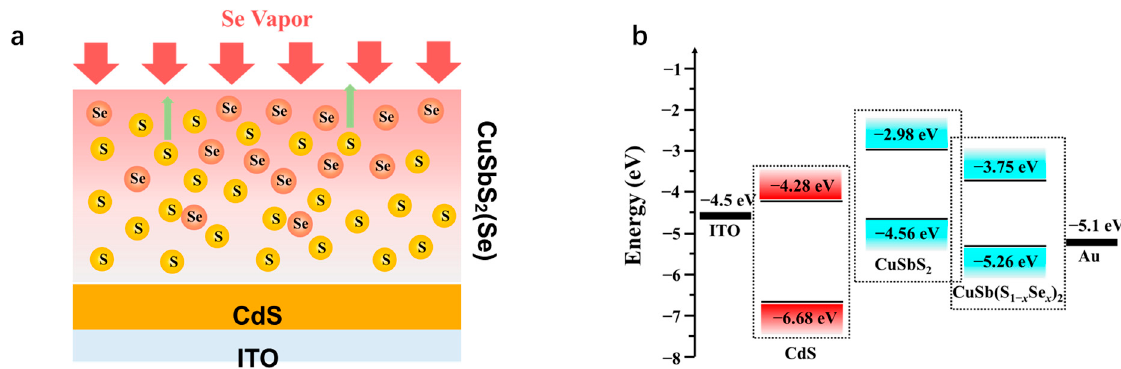
Figure 8. Energy band structure analysis of CdS/CuSbS 2 (Se): ( a ) a sketch of Se distribution in CuSbS 2 (Se) and ( b ) energy level of CdS/CuSbS 2 (Se) heterojunction interface.